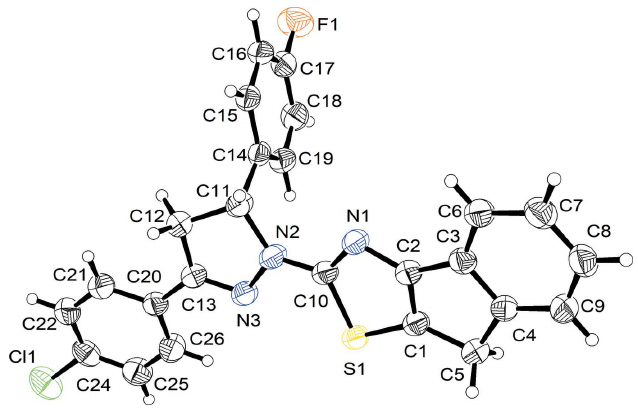
Figure 1 The molecular structure of the title compound showing 50% probability